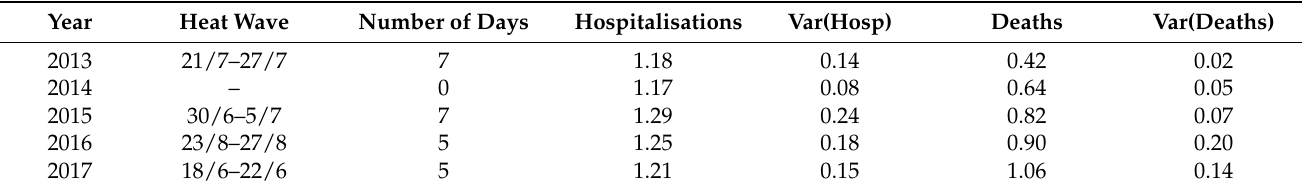
Table 2. Average number of hospitalisations and deaths calculated per 1,000 residents per day. Variance (Var), hospitalisa- tion (hosp).